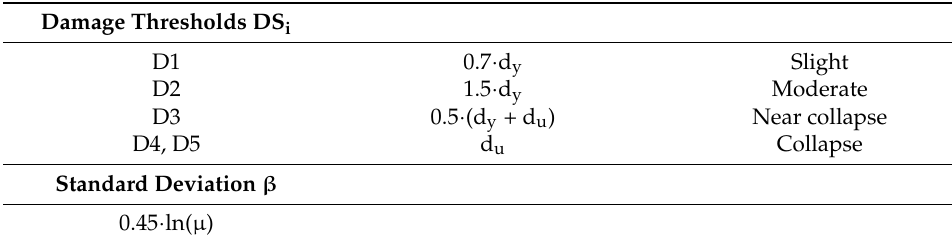
Table 3. Damage levels, DS i, and the corresponding dispersion, β .